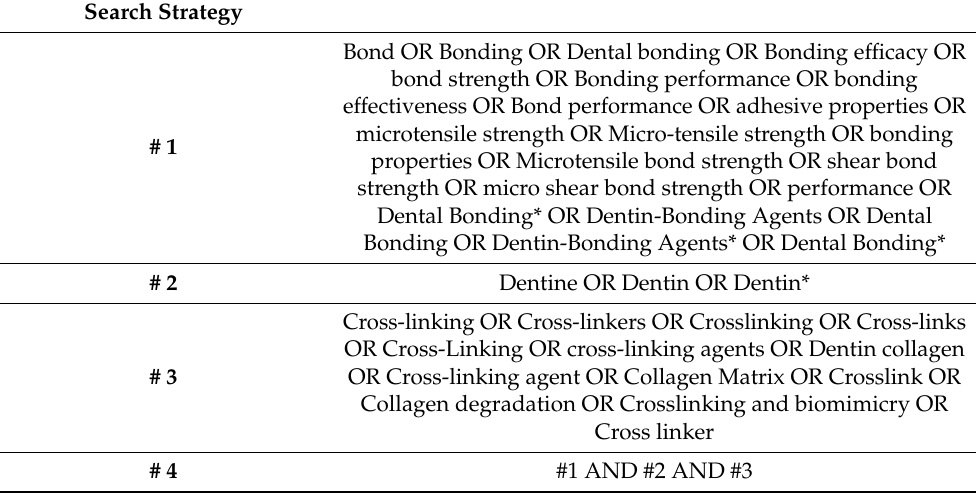
Table 1. Search strategy used in